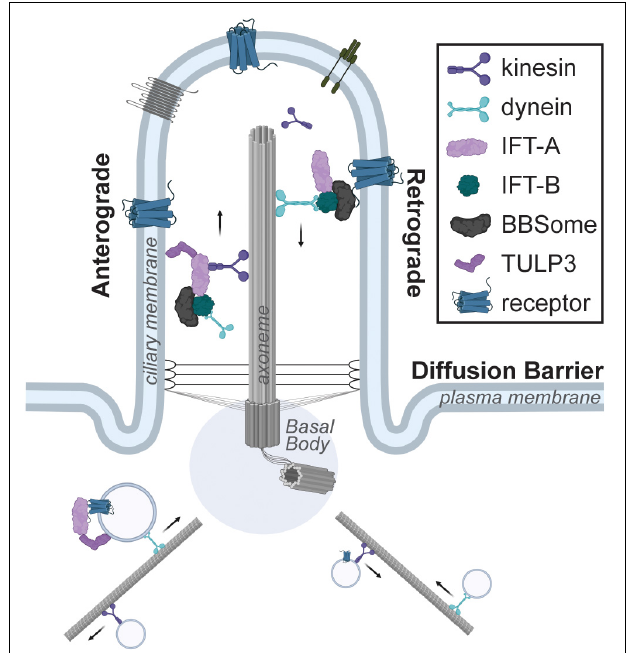
FIGURE 1 | Schematic of the primary cilium. The cilium is composed of a microtubule-based axoneme and the surrounding ciliary membrane, which is highly enriched for receptors. The intraflagellar transport system couples to kinesin or dynein motors for anterograde or retrograde transport within the cilium. Trafficking of ciliary cargo such as receptors into or out of the primary cilium is tightly regulated and requires adaptor proteins such as TULP3 or the BBSome complex,